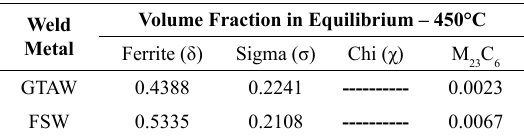
Table 6. Phase composition and volume fraction predictions from Thermocalc ® to weld metals aged at 450 °C.